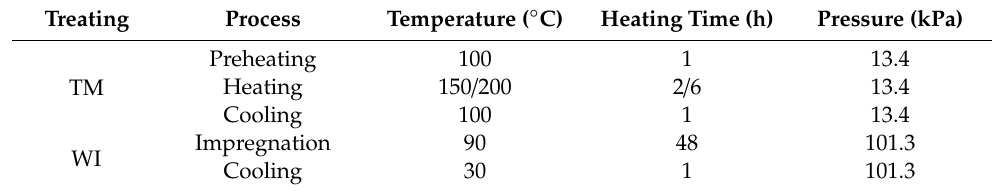
Table 1. Experimental parameters for thermal modification (TM) and wax impregnation (WI)